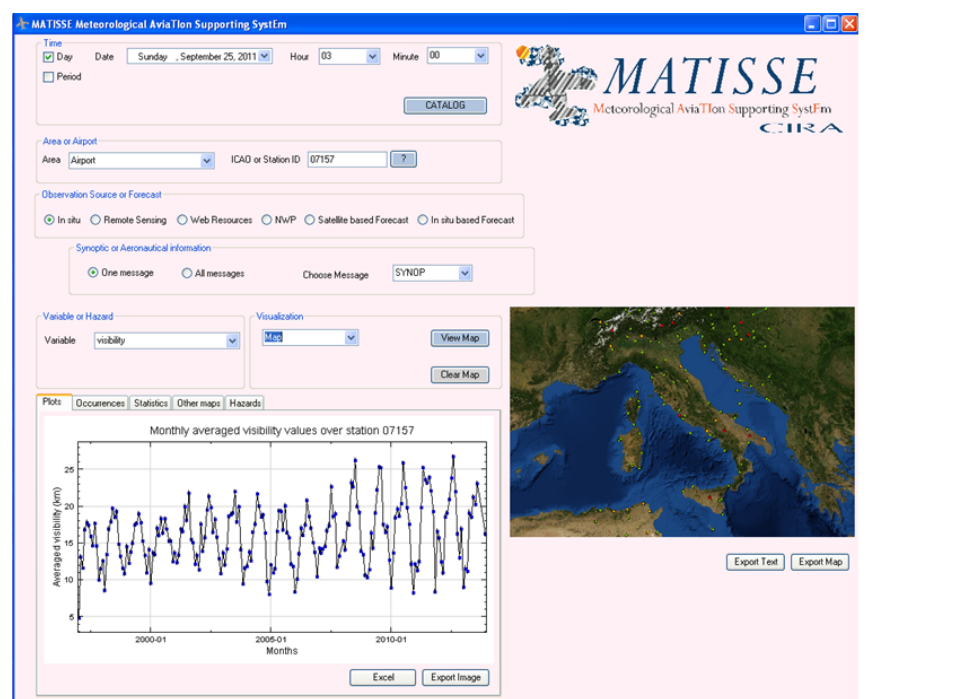
Figure 2. MATISSE graphical